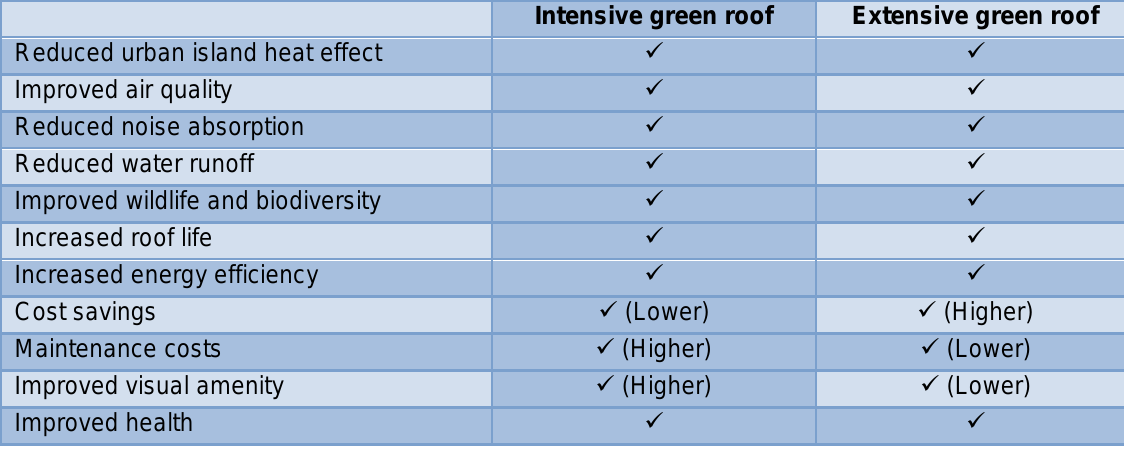
Table 2 Benefits of Intensive and Extensive Green Roof Systems Although there are many benefits for constructing green roof systems, the extensive green roofs are still not commonly used in Hong Kong. The major constraints for the use of extensive green roof systems